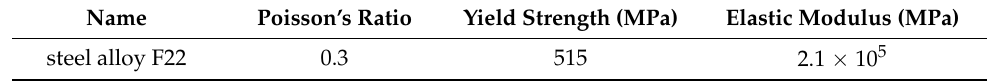
Table 2. Mechanical properties of the